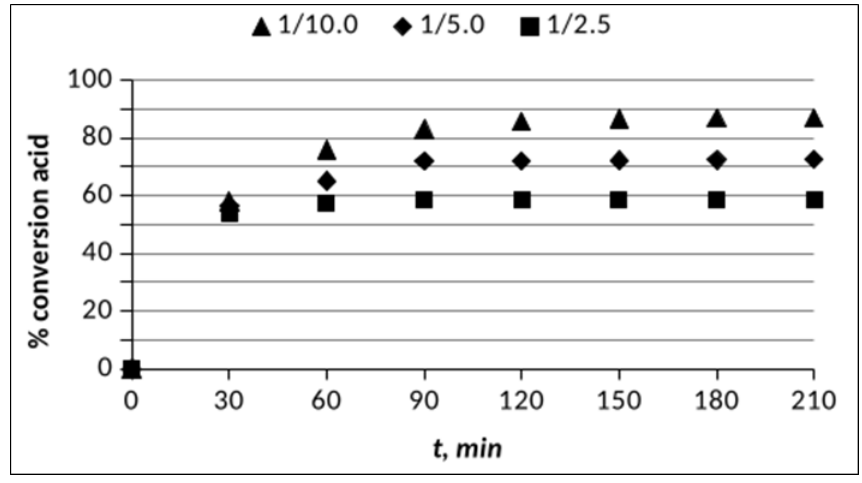
Figure 3. Effect of acid/alcohol molar ratio (1/10; 1/5 and 1/2.5) on the rate of esterification of propanoic acid with